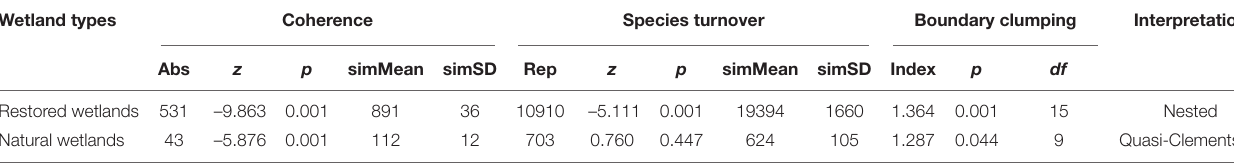
TABLE 1 | Results of the elements of metacommunity structure analysis in restored and natural wetlands. Wetland types Species turnover Boundary clumping Interpretation